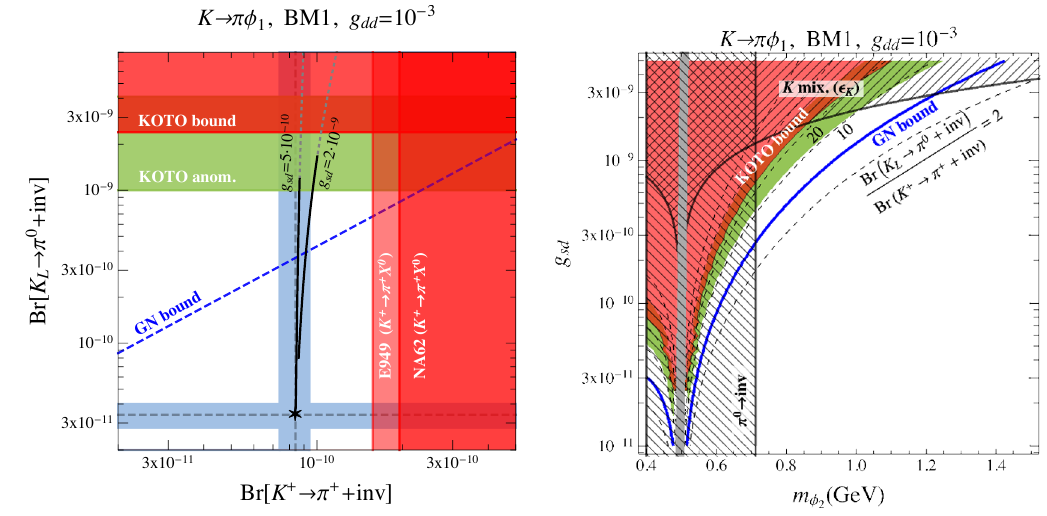
Figure 5 . The parameter space for Model 1, BM1, for g dd = 10 (cid:0) 3 in (3.35). The GN bound is denoted with blue lines, while the green regions give the 1 (cid:27) bands corresponding to KOTO (cid:25) + + inv), Br( K L (cid:25) 0 + inv), anomalous events [10, 12]. Left: the predictions for Br( K + ! ! varying m (cid:30) [0 : 4 ; 1 : 5] GeV and for two values of g sd (black lines). The values closest to the SM 2 2 (black cross) are reached for m (cid:30) = 1 : 5 GeV. Blue regions are the 1 (cid:27) SM prediction bands, with 2 the central values denoted by the dashed lines and a star, red regions are excluded by NA62 [40], (cid:25) 0 + inv) = Br( K + (cid:25) + + inv) (dashed E949 [29] and KOTO [9]. Right: contours of Br( K L ! ! (cid:22) K 0 mixing and (cid:25) 0 inv lines) as functions of g sd , m (cid:30) , with the hatched regions excluded by K 0 2 (cid:0) ! bounds. The region around the kaon mass is masked out (gray region).